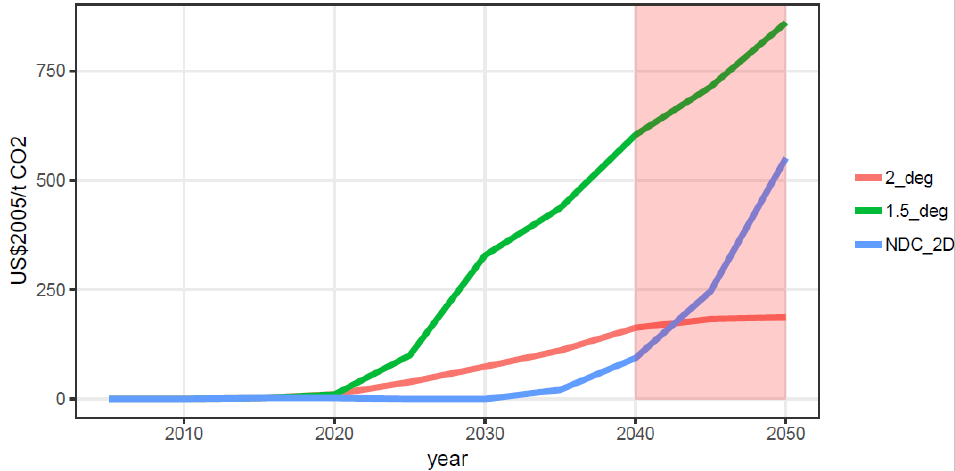
Figure 2. Carbon price in different mitigation scenarios.